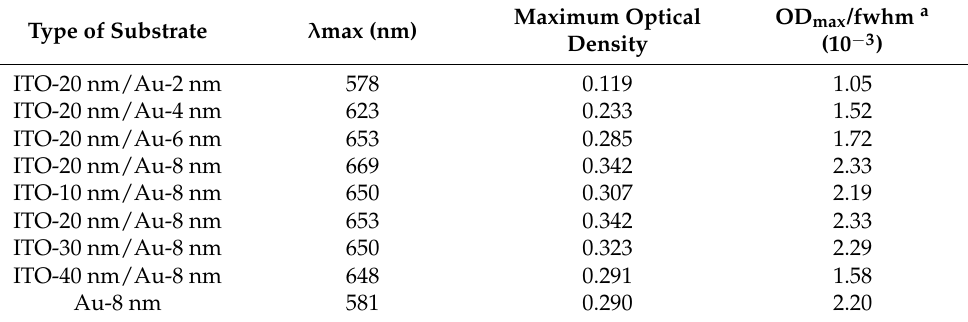
Table 1. LSPR analytical performances of annealed ITO/Au NPs on coverslips. Type of